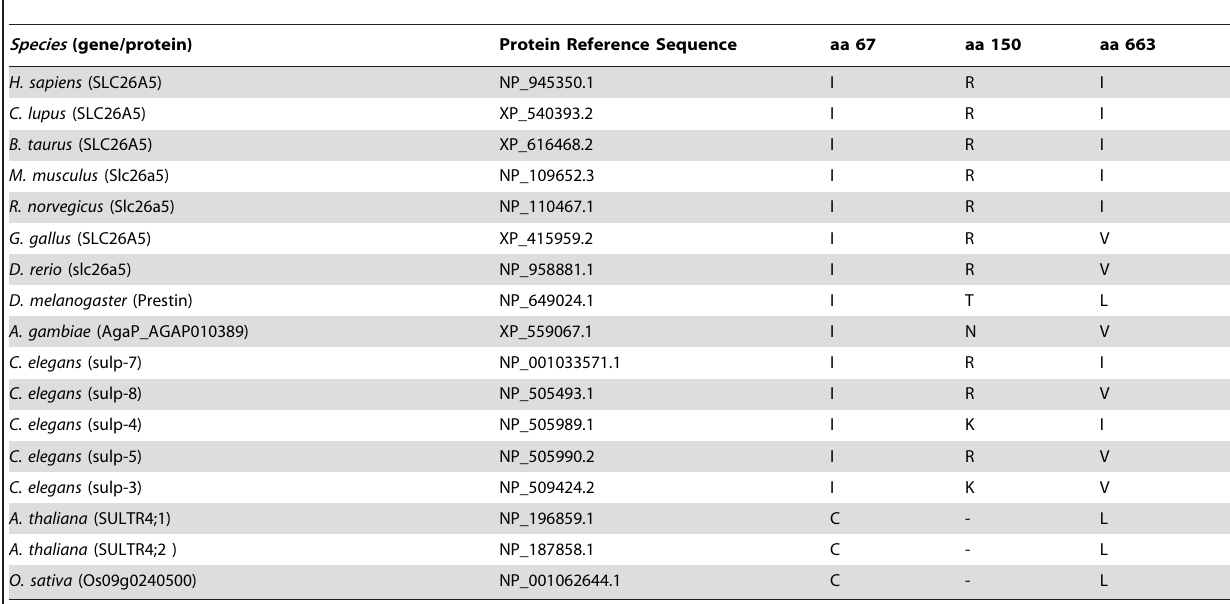
Amino acid alignments of prestin orthologs from various species are shown using H. sapiens as the anchor sequence. Amino acid (aa) positions 67, 150, and 663 indicated in the top row of columns 3–5 refer to the amino acid positions in the human prestin amino acid sequence. Reference sequences used are derived from the